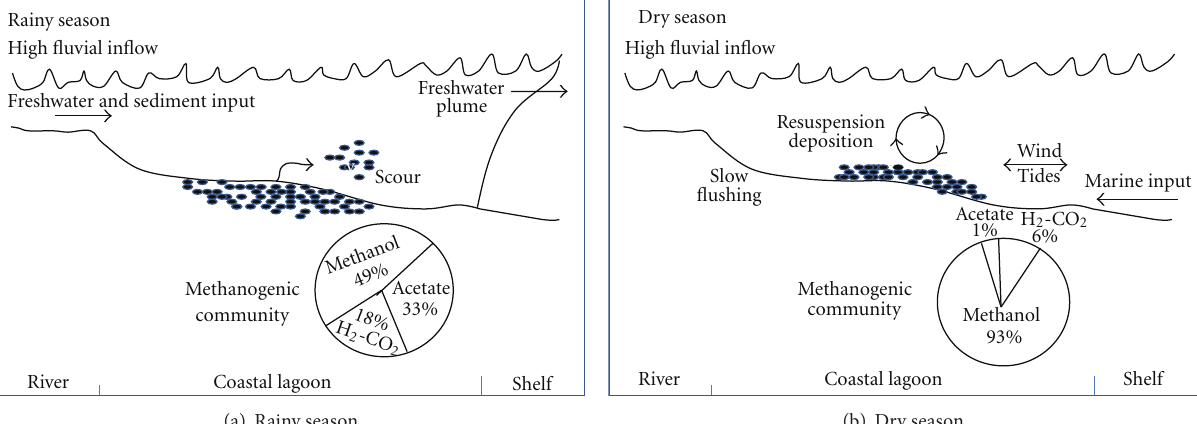
F 5: Conceptual model on MA dynamics in sediments for tropical coastal